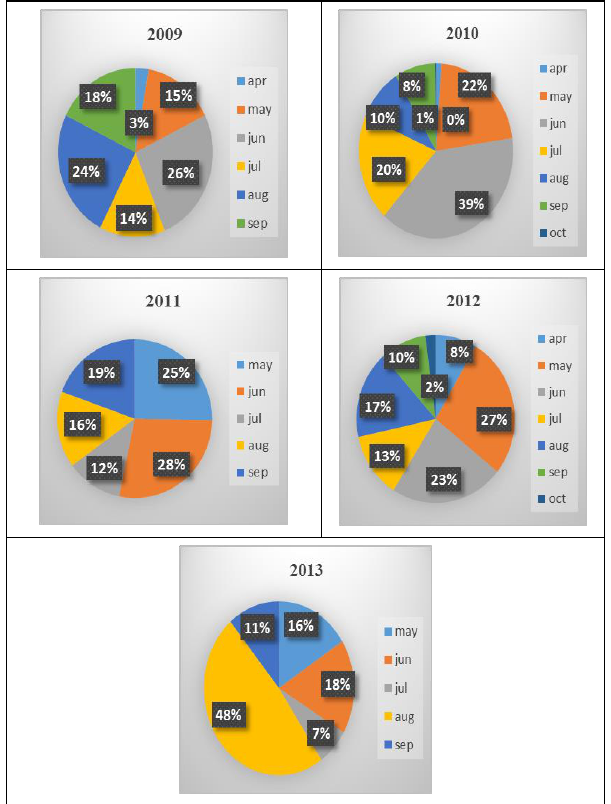
Figure 5. Moran’s I clustering in Guilan province (2009-2013).